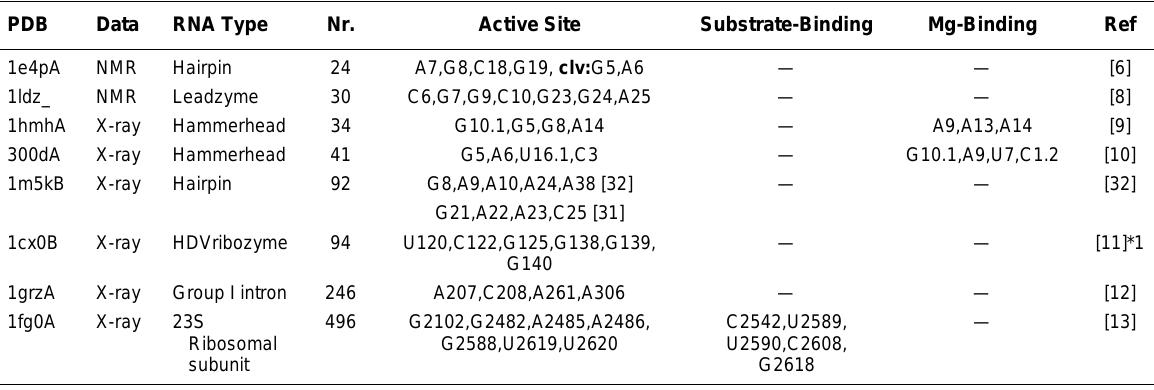
The Known Functional Nucleotides in the